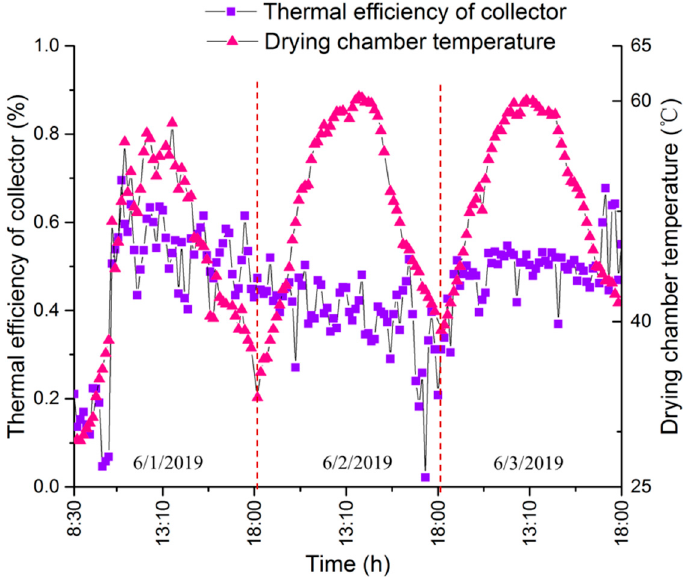
Figure 14. The change of drying chamber air temperature and thermal efficiency.